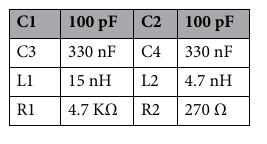
Table 5. Design parameters of the